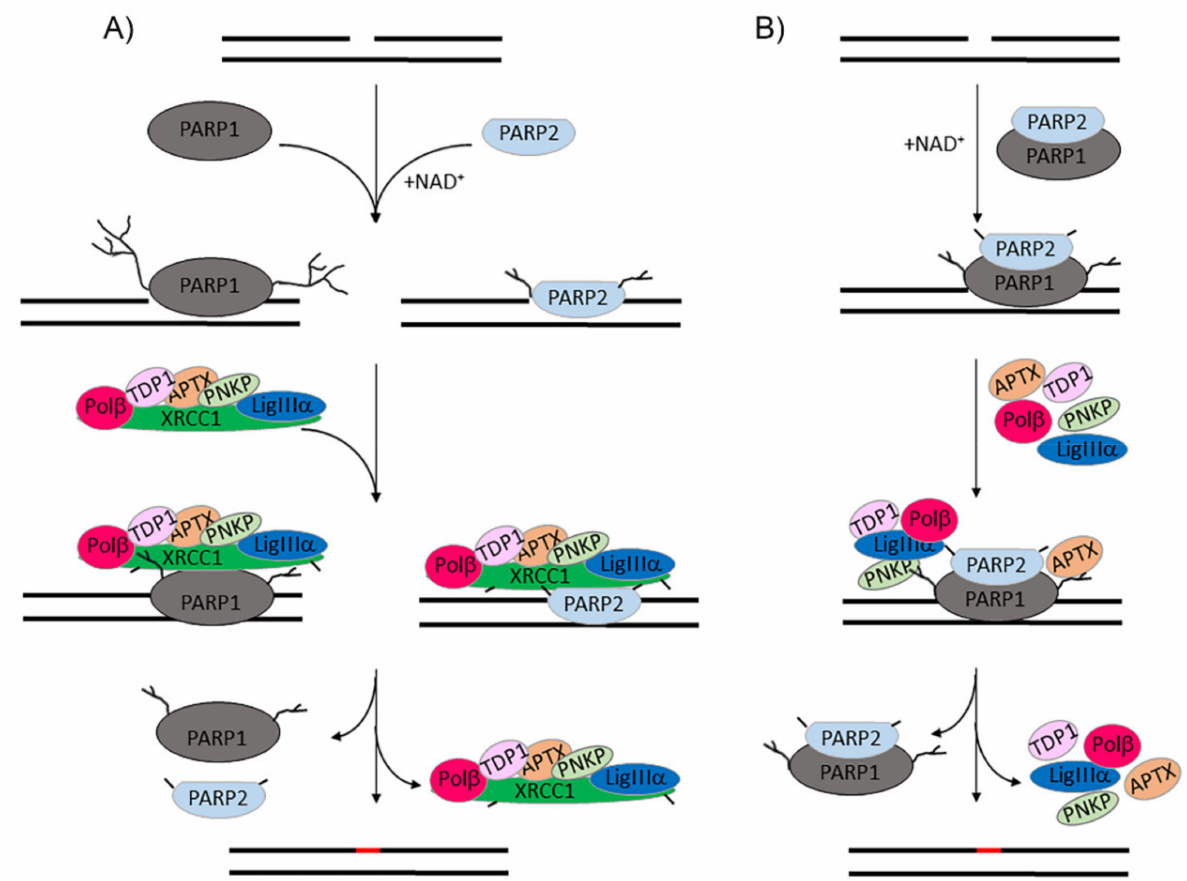
Figure 6. Functions of PARP2 in BER. ( A ) PARP1 and PARP2 perform overlapping functions in SSB detection with following activation and autoPARylation, and PAR-mediated recruitment of XRCC1 and BER enzymes involved in processing DNA damage. The activities of PARPs 1 and 2 are unequally regulated by XRCC1; the more efficient inhibition of PARP2 suggests its prevailing contribution at limited XRCC1 concentrations. ( B ) Hetero-oligomerization of PARP2 with PARP1 negatively regulates the efficiency of PAR synthesis. The autoregulatory behaviour of the PARP1–PARP2 complex enables SSB repair through an XRCC1-independent